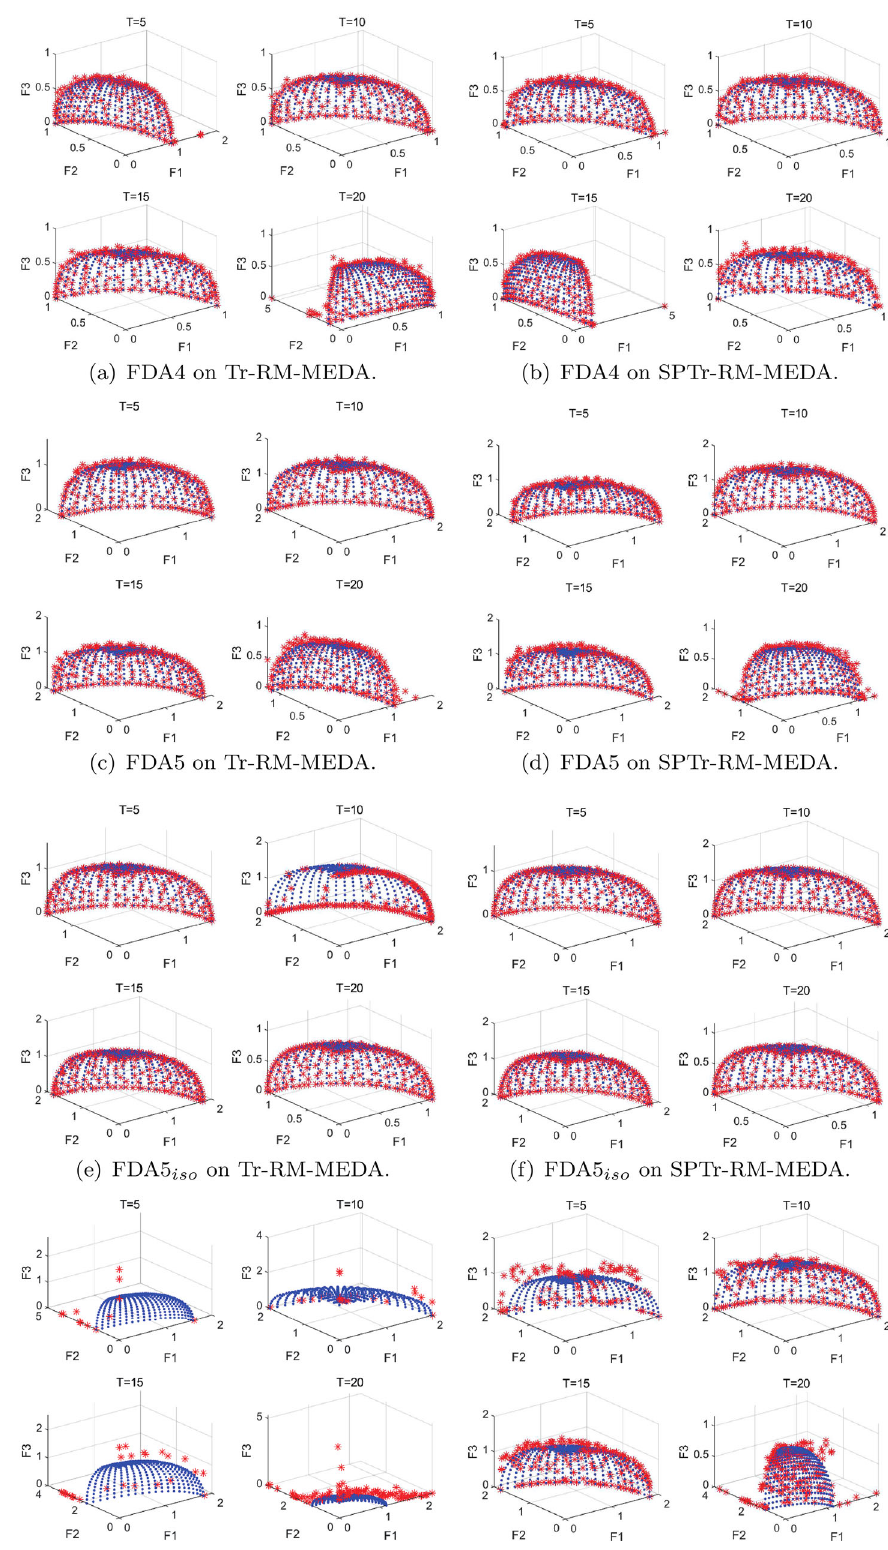
Fig. 3 Comparative PFs on different environments (T=5, 10, 15 and 20) for three-objective problems under